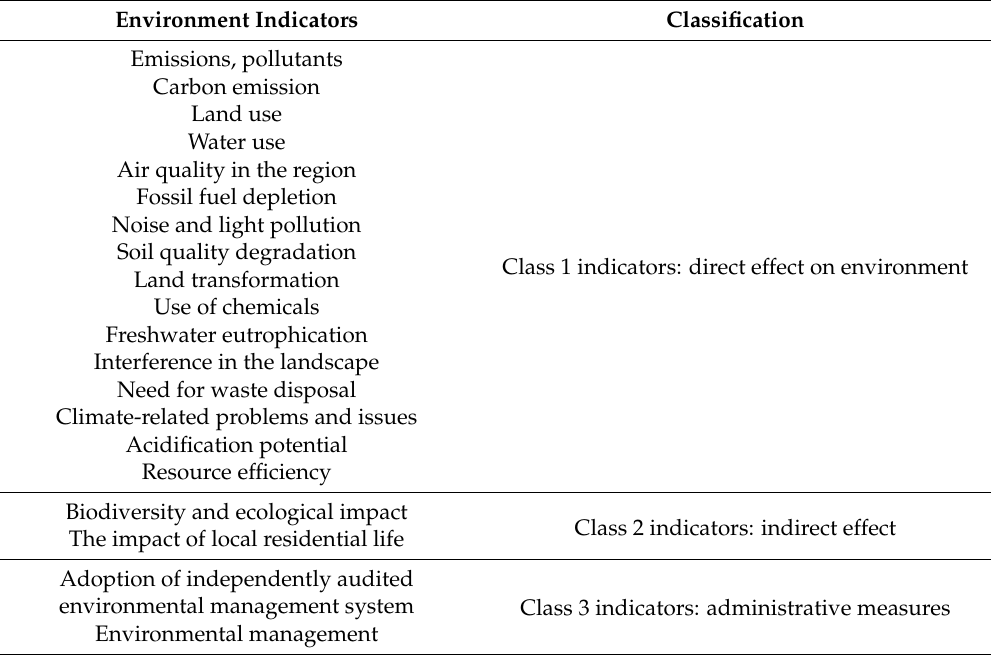
Table 3. The most commonly utilized environment indicators.